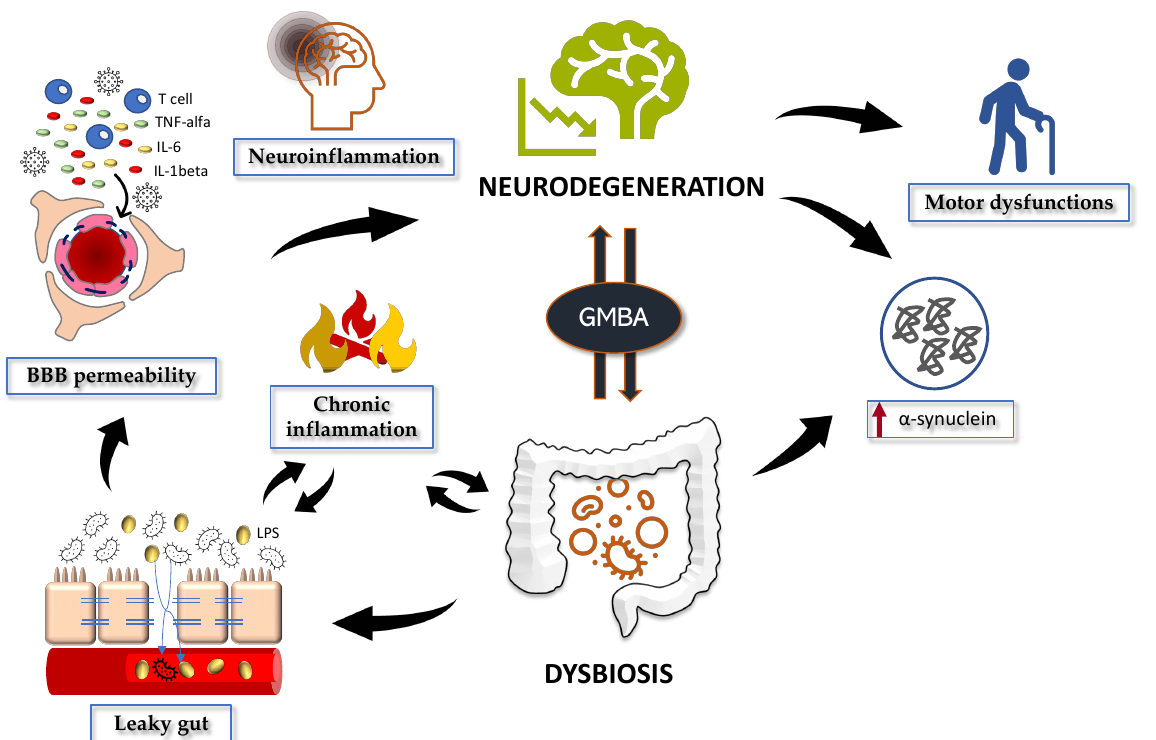
Figure 1. The gut microbiota brain axis (GMBA) in Parkinson’s disease (PD). In PD, α-synuclein aggregates are retrieved both in the dopaminergic neurons of the substantia nigra , as well as in the gut, and often associate to intestinal dysbiosis. Dysregulations in the gut microbiota composition trigger chronic inflammation and blood brain barrier (BBB) disruption through increased gut permeability (the so-called leaky gut). The resulting neuroinflammation then directly or indirectly promotes cognitive decline and motor dysfunction, which are the typical PD manifestations. ↑ :